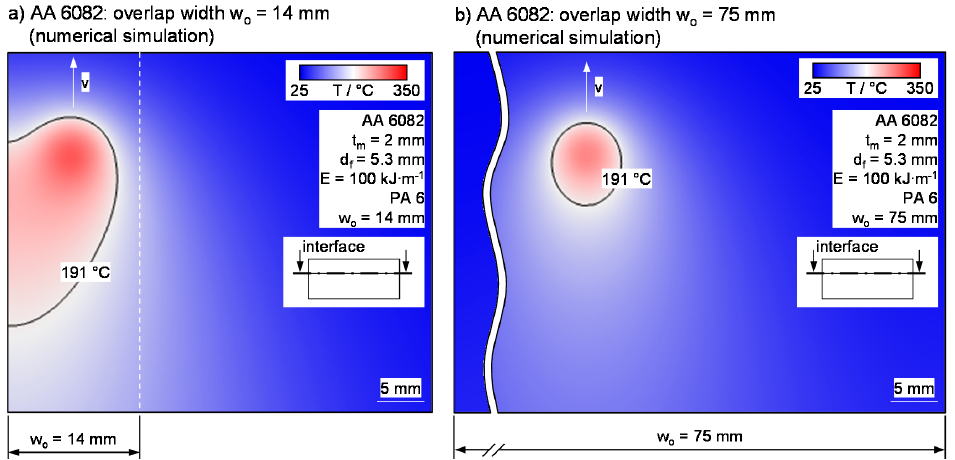
Figure 8. ( a ) Temperature distribution in the interface for an AA 6082–PA 6 joint width overlap widths of 14 and ( b ) 75 mm based on numerical simulations.